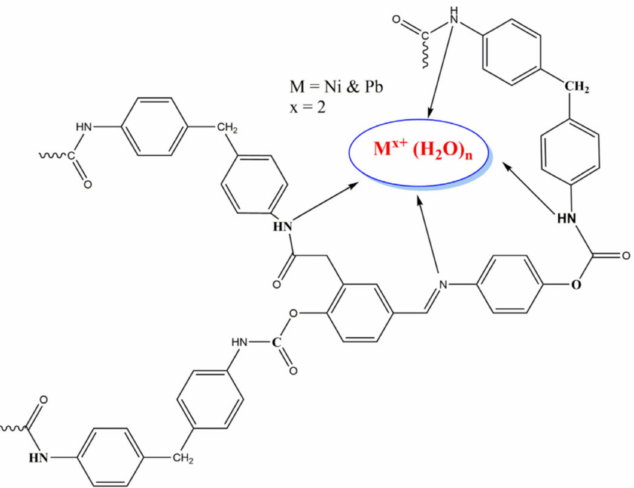
Figure 10. Adsorption mechanism of PU. Reused with permission from